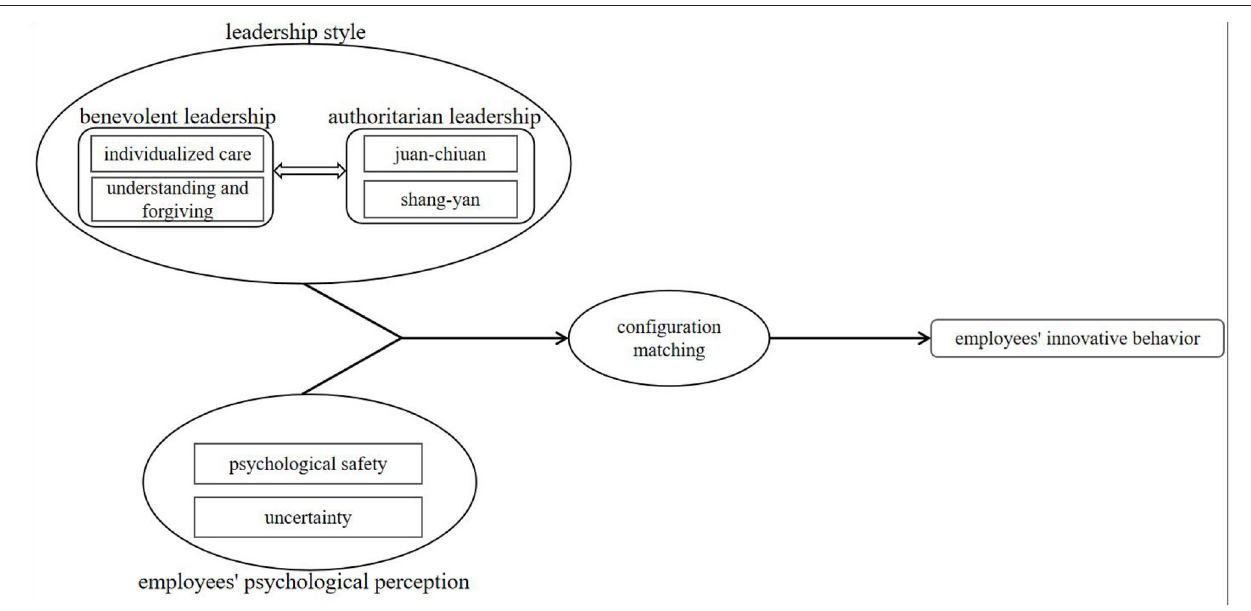
FIGURE 1 | Research model of the study.